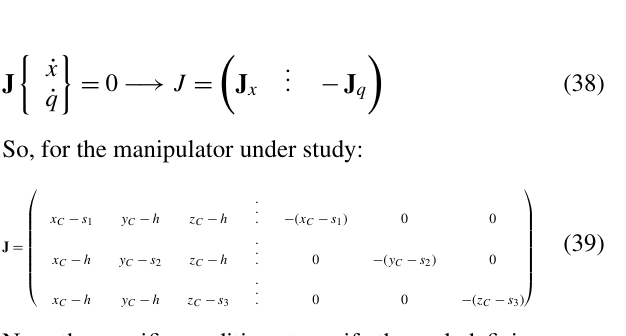
Increased mobility singularities occur when the complete Jacobian matrix is rank deficient. The complete Jacobian is defined